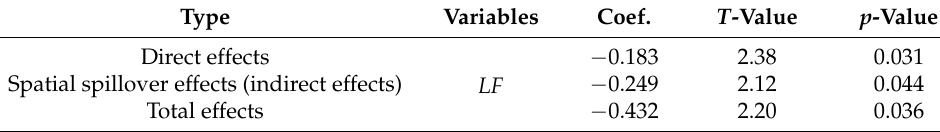
Table 6. Decomposition of spatial